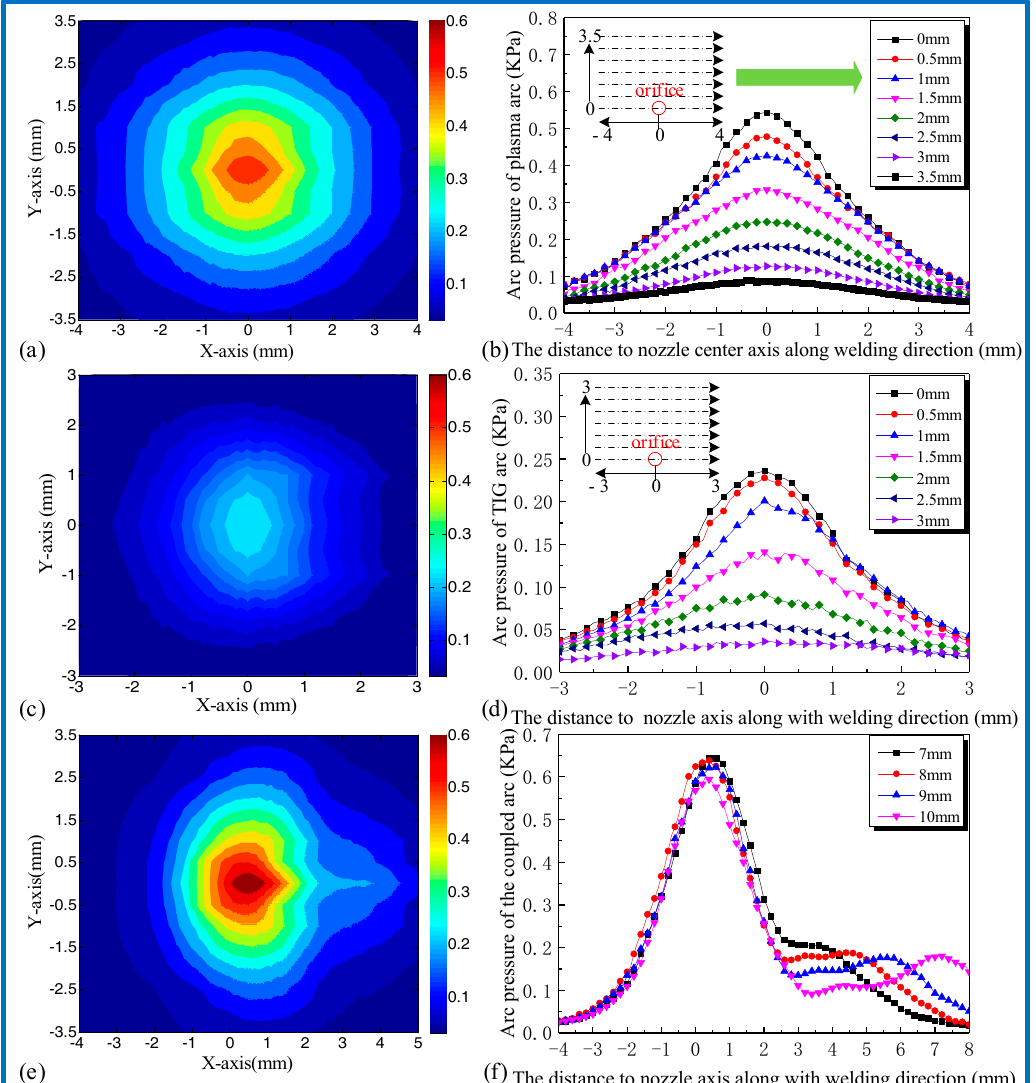
The distance to nozzle axis along with welding direction (mm) Figure 8. Stagnation pressure distribution of welding arc with the different method. ( a ) Top view of two-dimensional distribution of the plasma arc. ( b ) The plasma arc pressure along with welding direction with different distance to measurement orifice axis. ( c ) Top view of two-dimensional distribution of the TIG arc. ( d ) The TIG arc pressure along with welding direction with different distance to measurement orifice axis. ( e ) Top view of two-dimensional distribution of the coupled arc. ( f ) The coupled arc pressure along with welding direction with different electrode spacing.